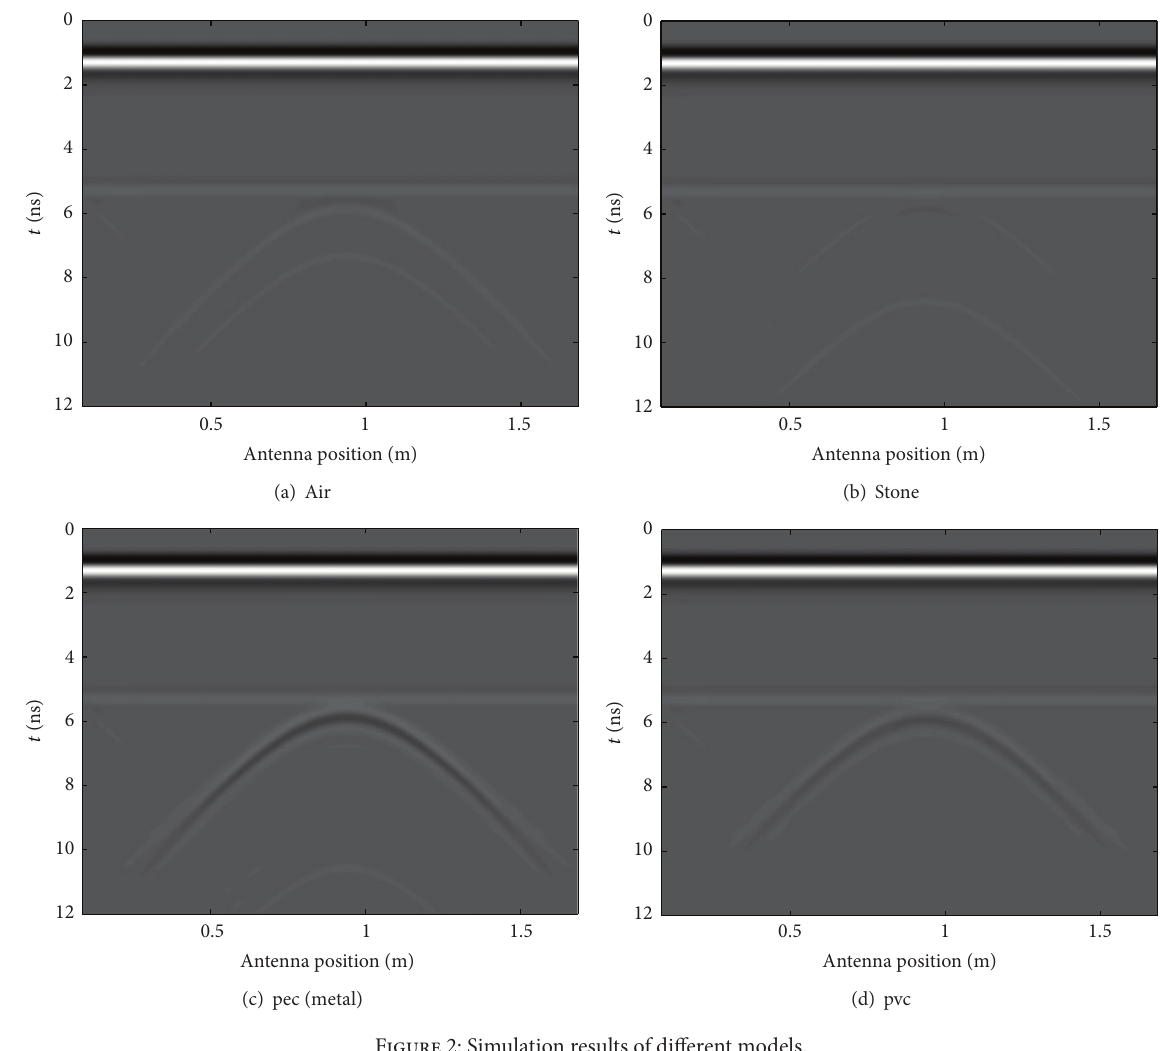
Figure 2: Simulation results of different models.